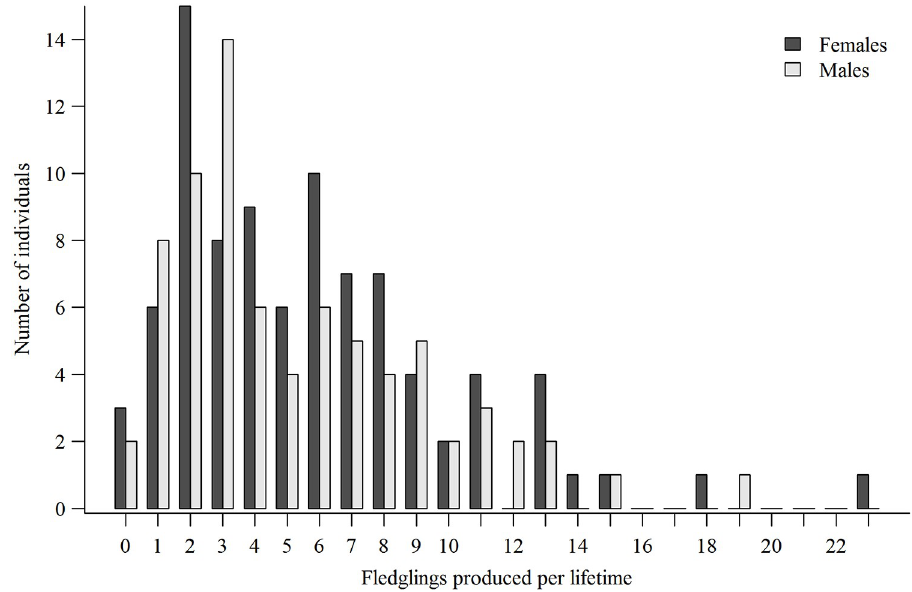
Fig 3. Number of fledglings produced by goshawks during their lifetimes. Individual lifetime reproduction (LR) of 75 males and 89 females of combined known-age and � 4-year-old goshawks first breeding in the 1992–2000 cohorts in Arizona, USA.